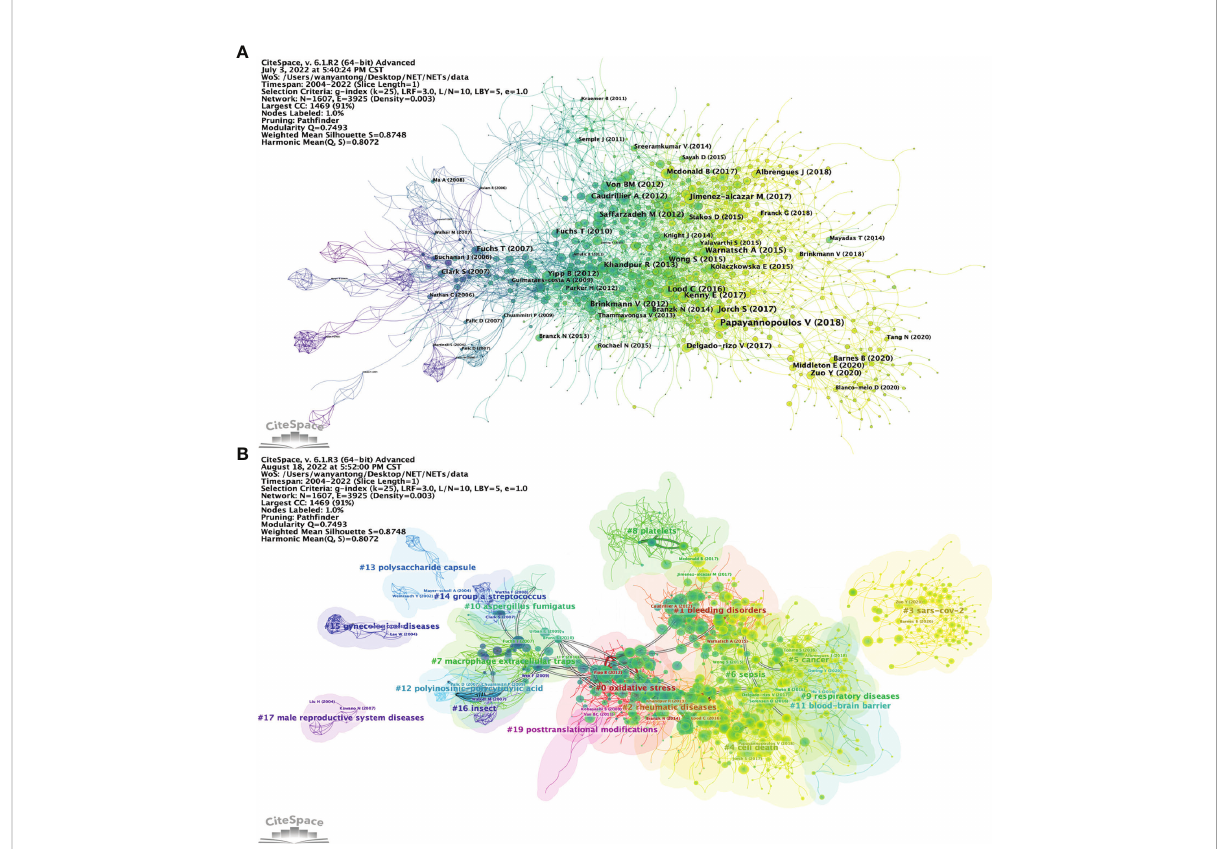
FIGURE 8 Analysis of NETs-related reference. (A) Analysis of the network of references in CiteSpace. Node size is proportional to the number of times the article is co-cited. (B) Clustering of references based on similarity between references, including #0 oxidative stress, #1 bleeding disorders, #2 rheumatic diseases, #4 cell death, #5 cancer, #9 respiratory diseases, #12 polyinosinic-polycytidic acid, #15 gynecological diseases, #16 insects, and #17 male reproductive system